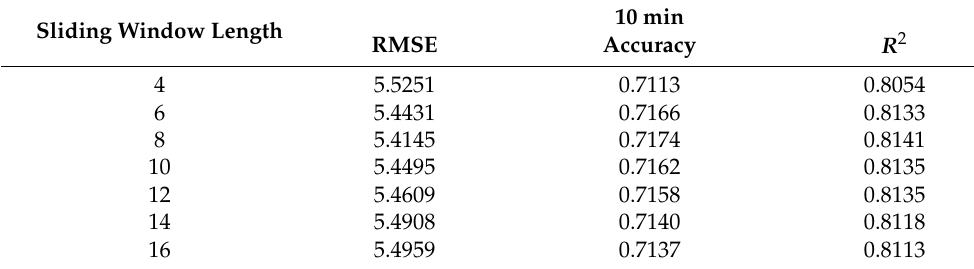
Table 2. The comparison results between the DC-STGCN and other baseline models.